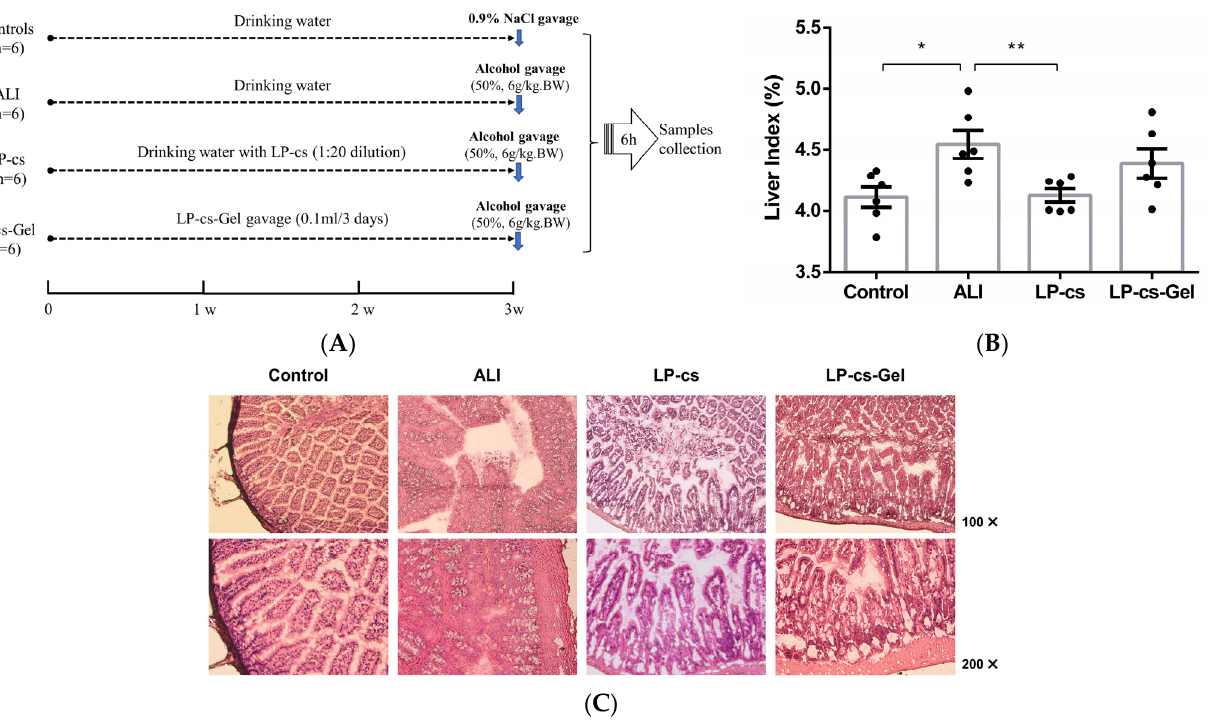
Figure 3. Animal experimental settings and morphology of the liver and intestine: ( A ) Animal experimental settings and schedules; ( B ) the liver index in each group of mice; the ratios were 0.041 ± 0.001, 0.045 ± 0.001, 0.041 ± 0.001, 0.044 ± 0.001 in the control, ALI, LP-cs, and LP-cs-Gel-presupplemented groups, respectively; ( C ) morphology of the proximal ileum by HE staining in each group of mice. Data are presented as individual data points as well as the mean ± SEM for each group, with n = 6 per group. P -values were determined by one-way ANOVA. * p < 0.05 and ** p < 0.01.